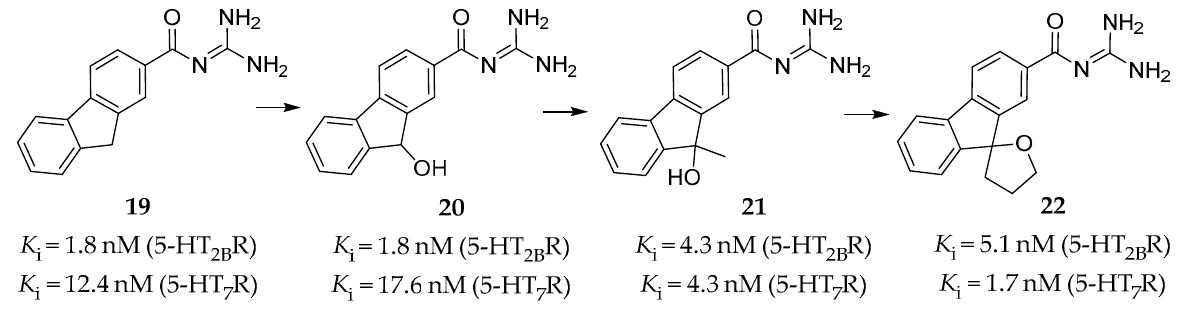
Figure 6. Carbonyl guanidine derivatives as dual 5-HT 2B R and 5-HT 7 R antagonists [135–137].